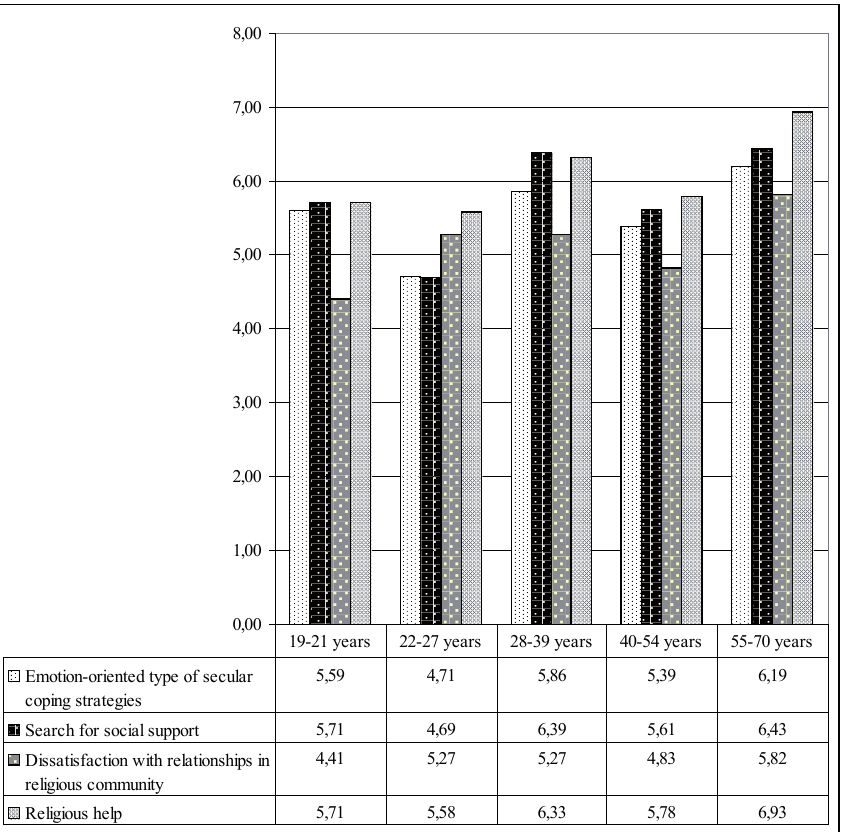
Fig. 1 . Statistically signi fi cant differences of average values of coping strategies indicators for women of various